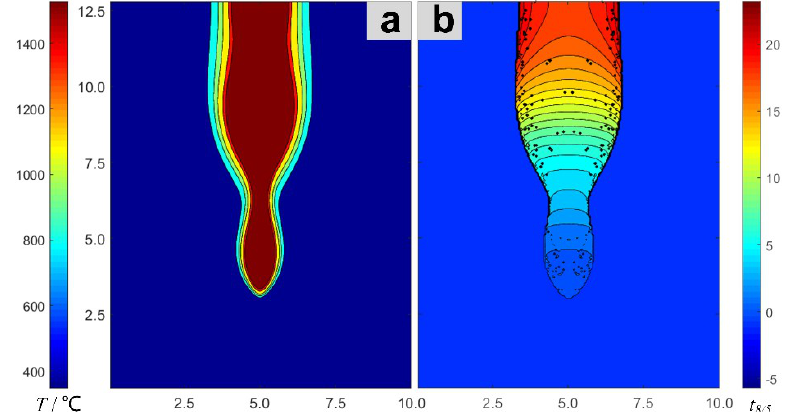
Figure 3. Maximum temperature field ( a ) and t 8 / 5 field ( b ) of the weld section.